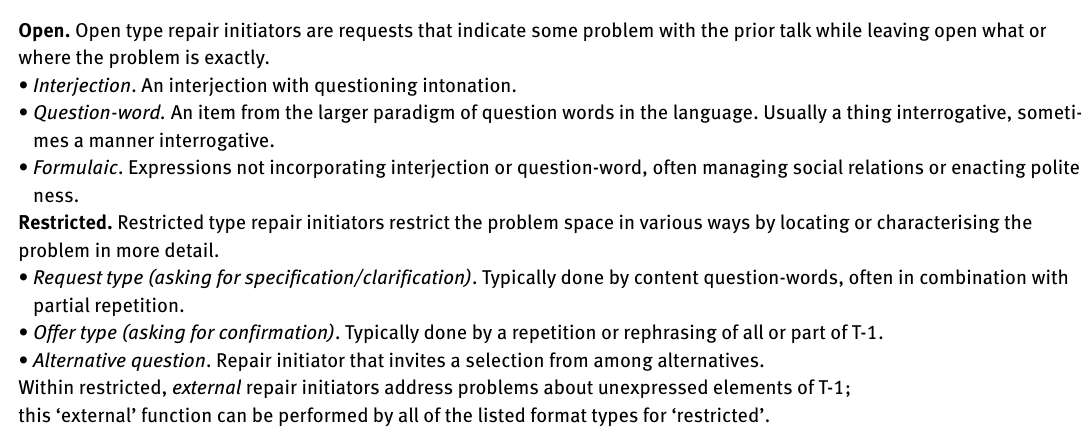
Table 6: Some basic format types for other-initiation of